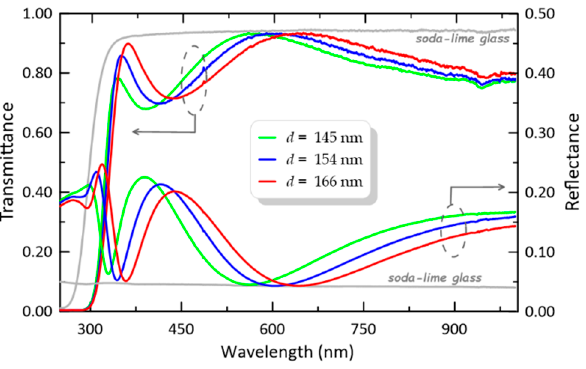
Figure 12. Transmittance and reflectance spectra of the SiO x :TiO y films for selected thickness.